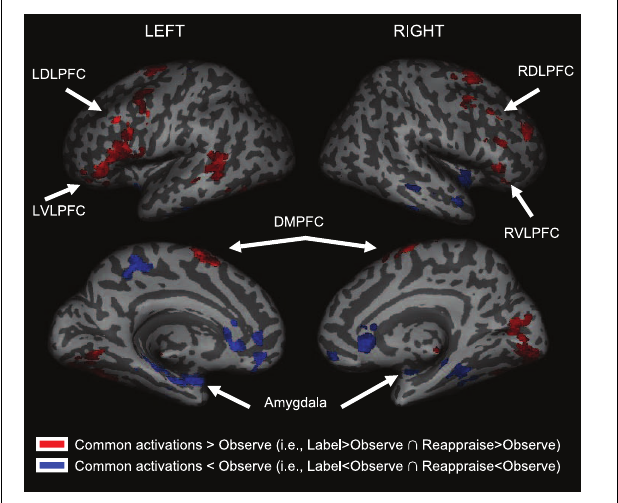
FIGURE 3 | Common activations for Labeling and Reappraisal relative to Observe only. Areas in red were commonly activated relative to the Observe condition. Areas in blue were commonly deactivated relative to the Observe